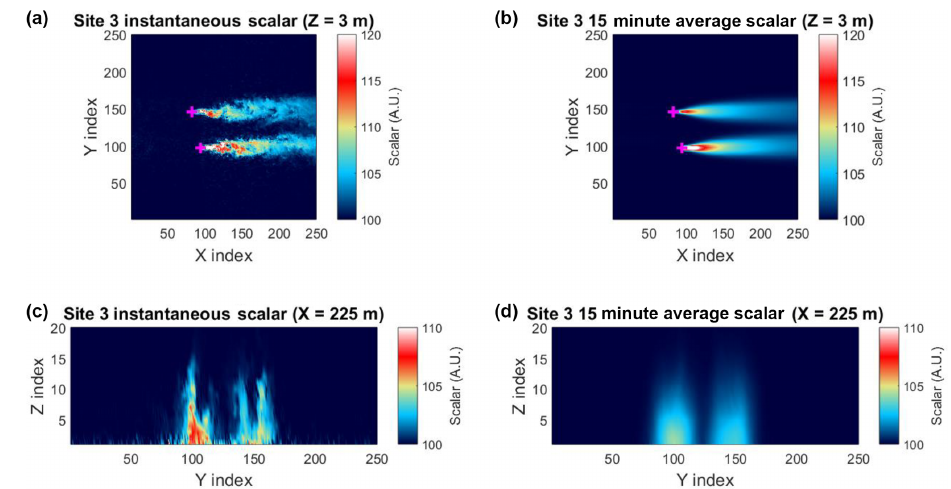
Figure 4. Comparison of instantaneous (a, c) and 15min averaged (b, d) plume for Site 3 from the LES. Panels (a) and (b) show the scalar with arbitrary units (A.U.) in (a) x – y cross section at an altitude of 3m and panels (c) and (d) show a x – z cross section at a 225m downwind distance. The release locations are shown with a magenta marker ( + ).